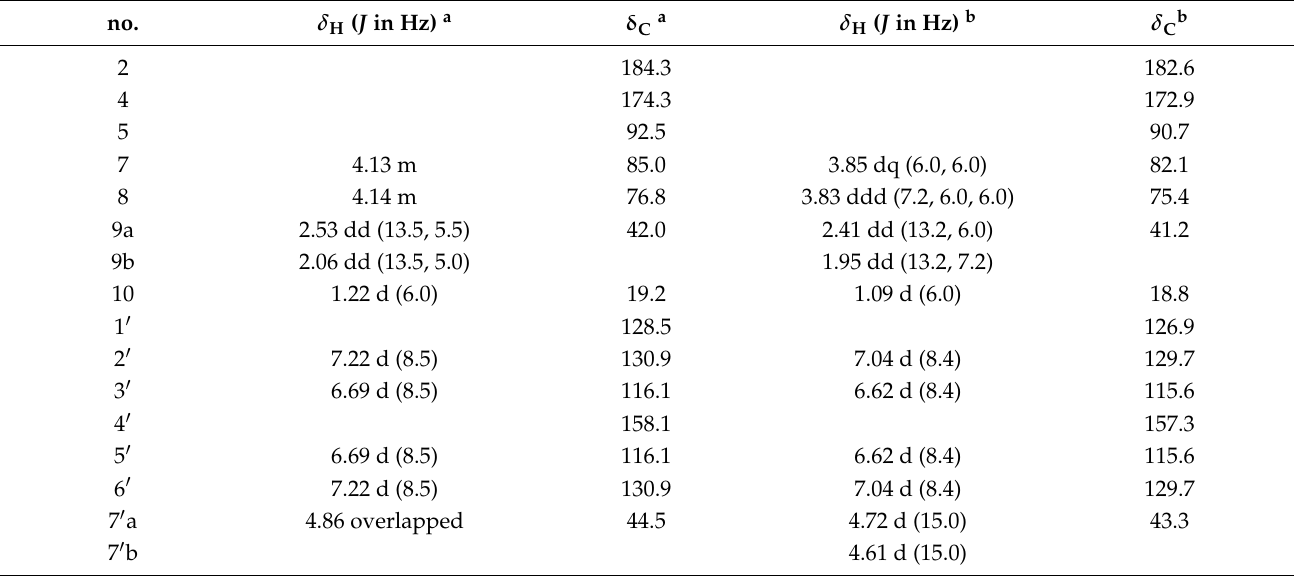
Table 1. 1 H and 13 C NMR data of Compound 1 .